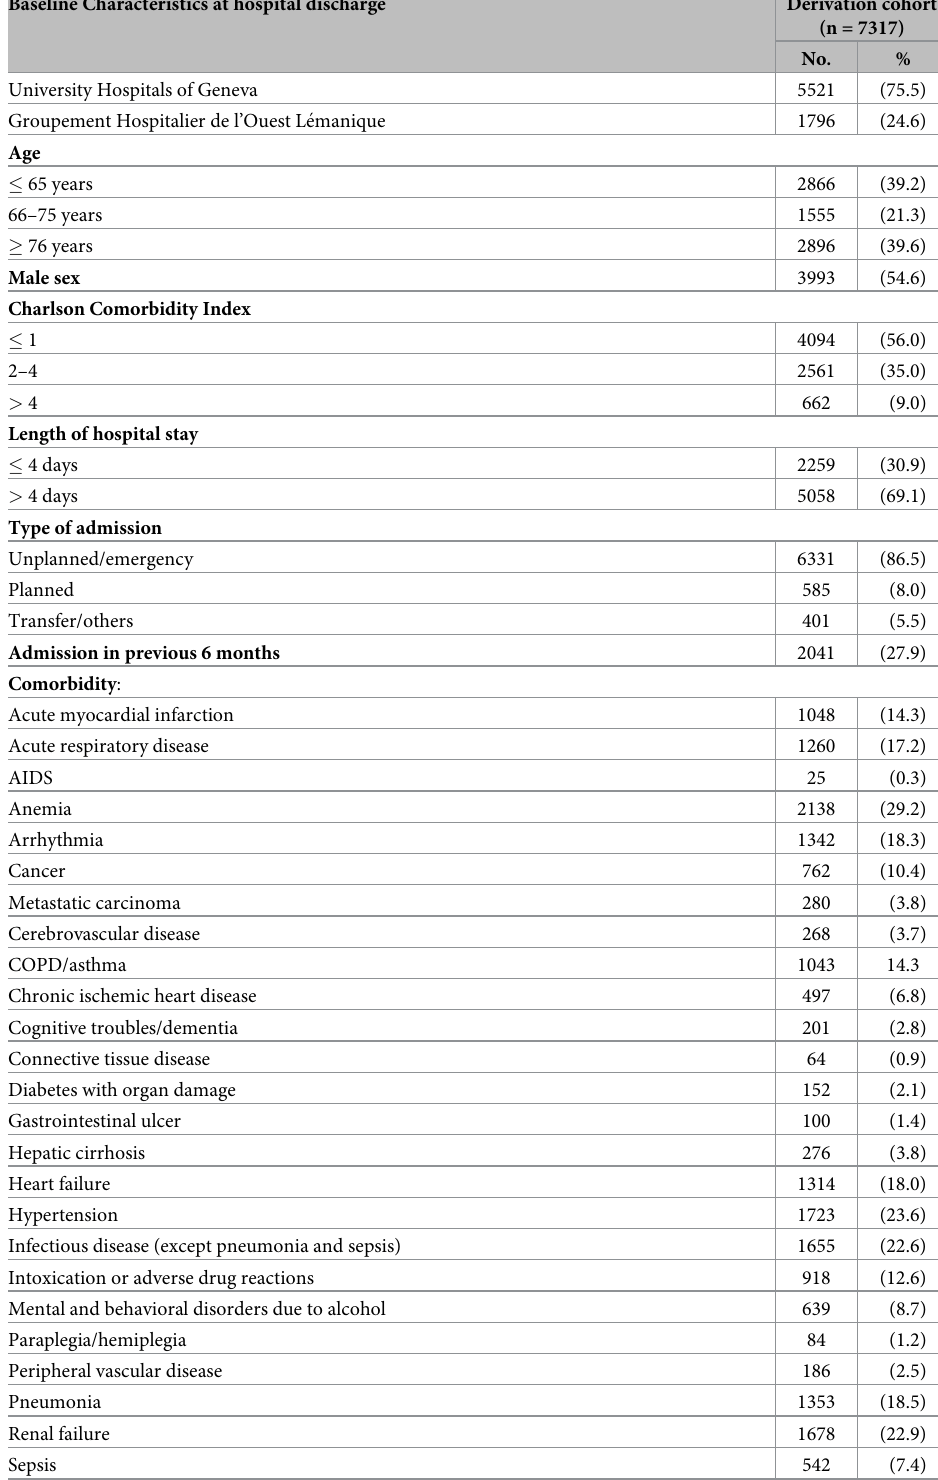
Table 1. Baseline characteristics of the derivation